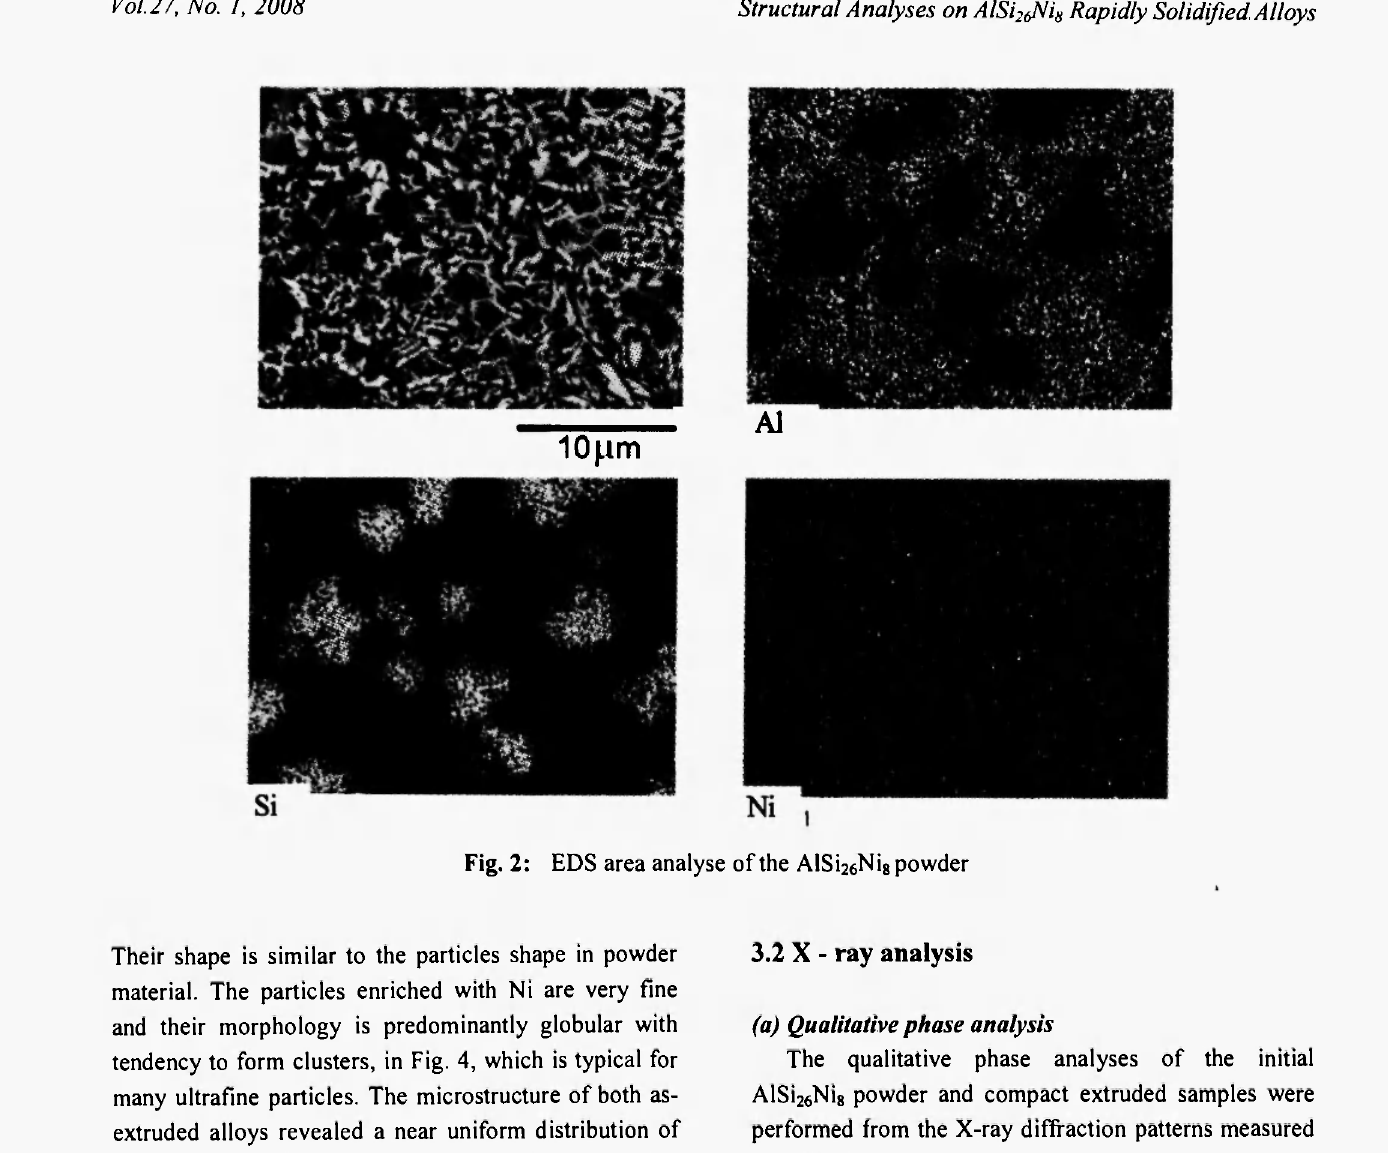
Fig. 2: EDS area analyse of the AISi 2 6Ni 8